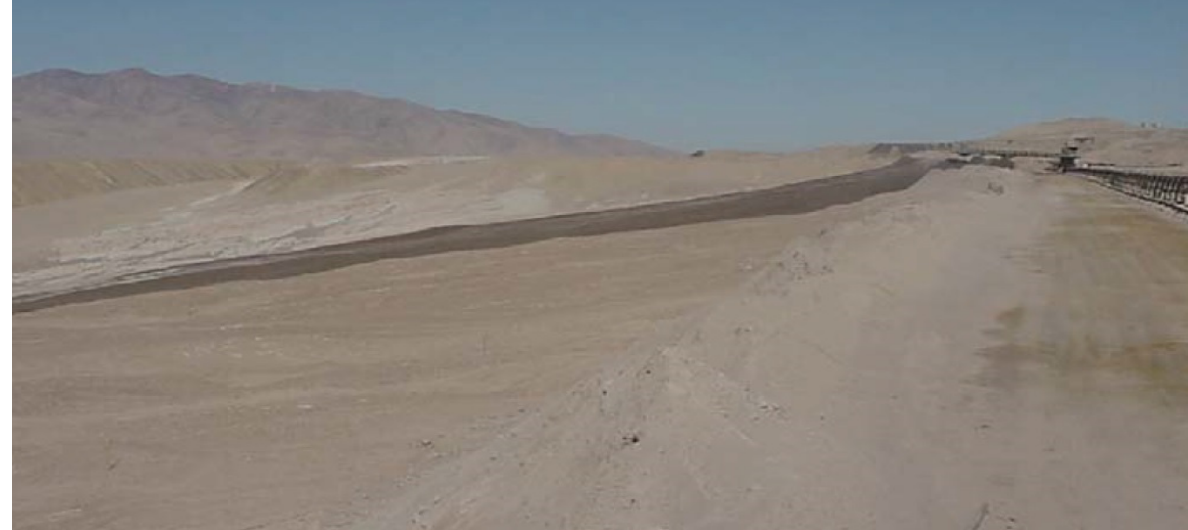
Figure 49. Mantos Blancos Disposal of Filtered Coarse Tailings with Mobile Stacker Conveyor and Tripper [18,67,68].